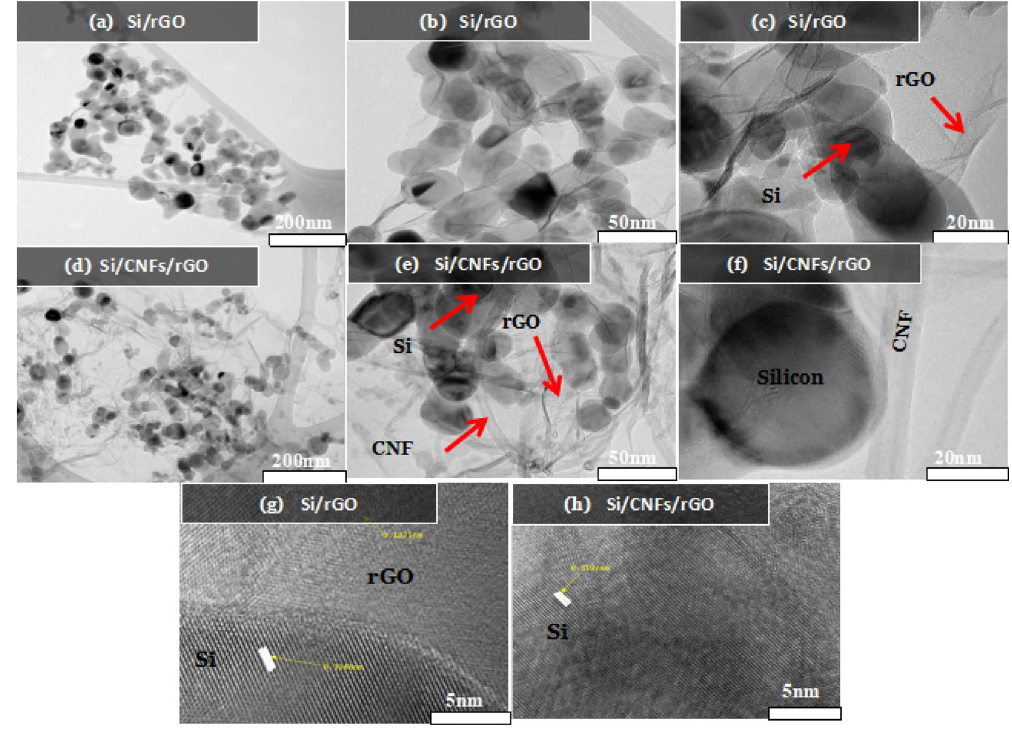
Figure 3. TEM images of ( a – c ) Si/rGO, ( d – f ) Si:CNF/rGO = 1:1 composites. High-resolution TEM images of ( g ) Si/rGO and ( h ) Si:CNF/rGO = 1:1 composites.